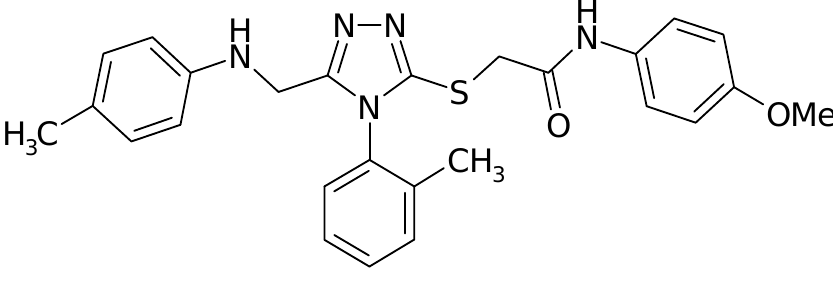
Fig. 1. (4-methoxyanilide 5-(4-methylphenylaminomethyl-4-(2-methylphenyl)-1,2,4-triazole-4H-3-ylthioglycolic acid